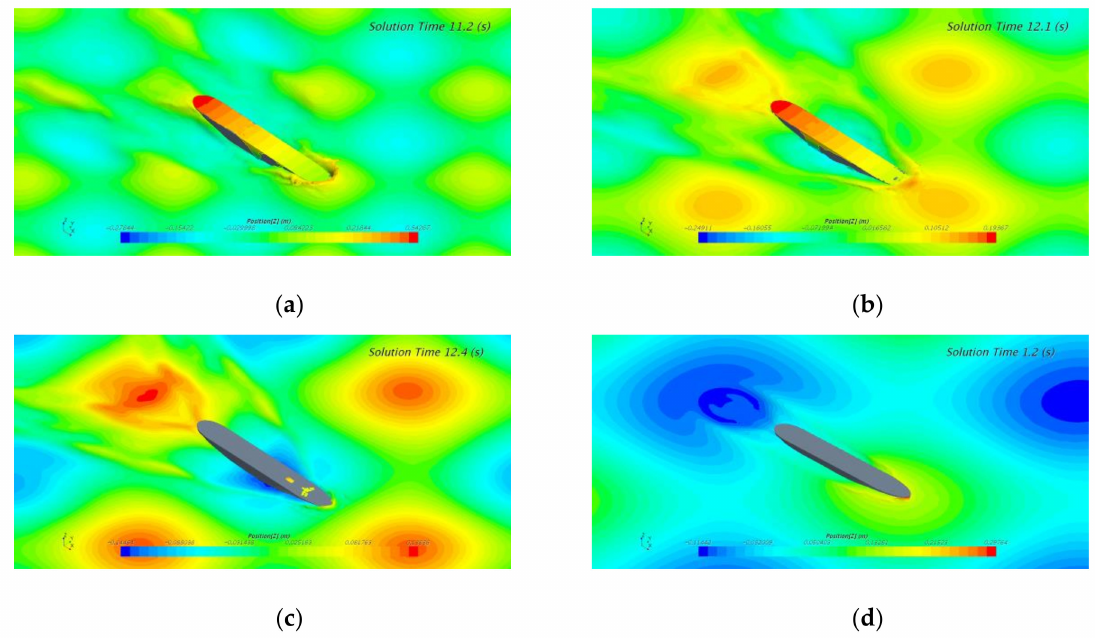
Figure 23. Green water on deck for ship in di ff erent wave length: ( a ) λ / L = 0.8; ( b ) λ / L = 1.2; ( c ) λ / L = 1.5; ( d ) λ / L =